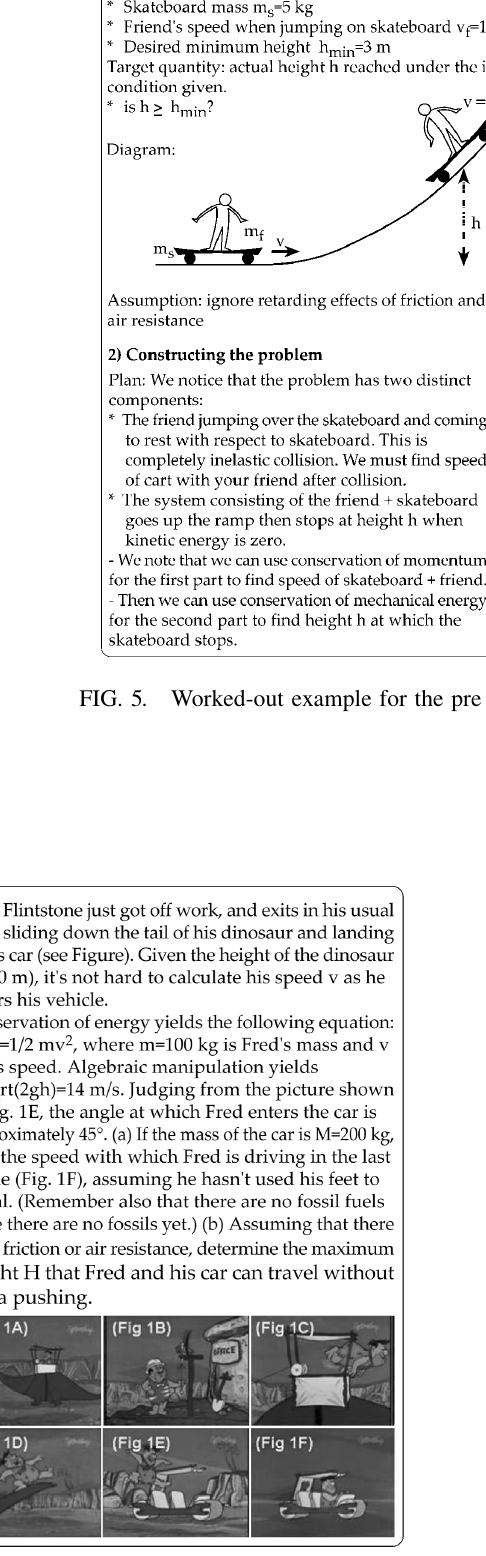
FIG. 6. The post (3rd midterm) problem.